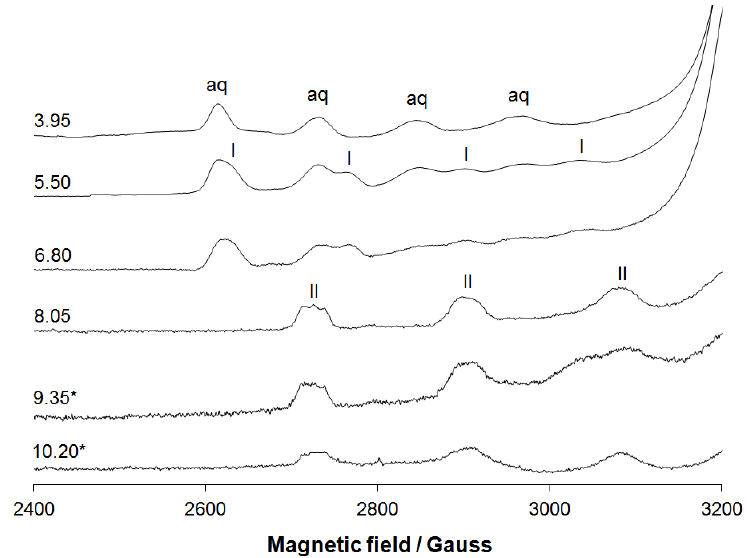
Figure 4. Low field region of the X-band anisotropic EPR spectra recorded at 77 K as a function of pH in an aqueous solution containing 63 CuSO 4 ·5H 2 O and HABH (LH 3 ) with a molar ratio of 1:1 and Cu(II) concentration of 1.0 × 10 –3 M. The values of pH are shown for each spectrum. The asterisk indicates that at pH 9.35 and 10.20 the solution was opalescent for the presence of the solid compound. With aq, I and II the first parallel resonances of aquation, and of the complexes with coordination (imine-N, CO) and (O − , imine-N, CO) are denoted.